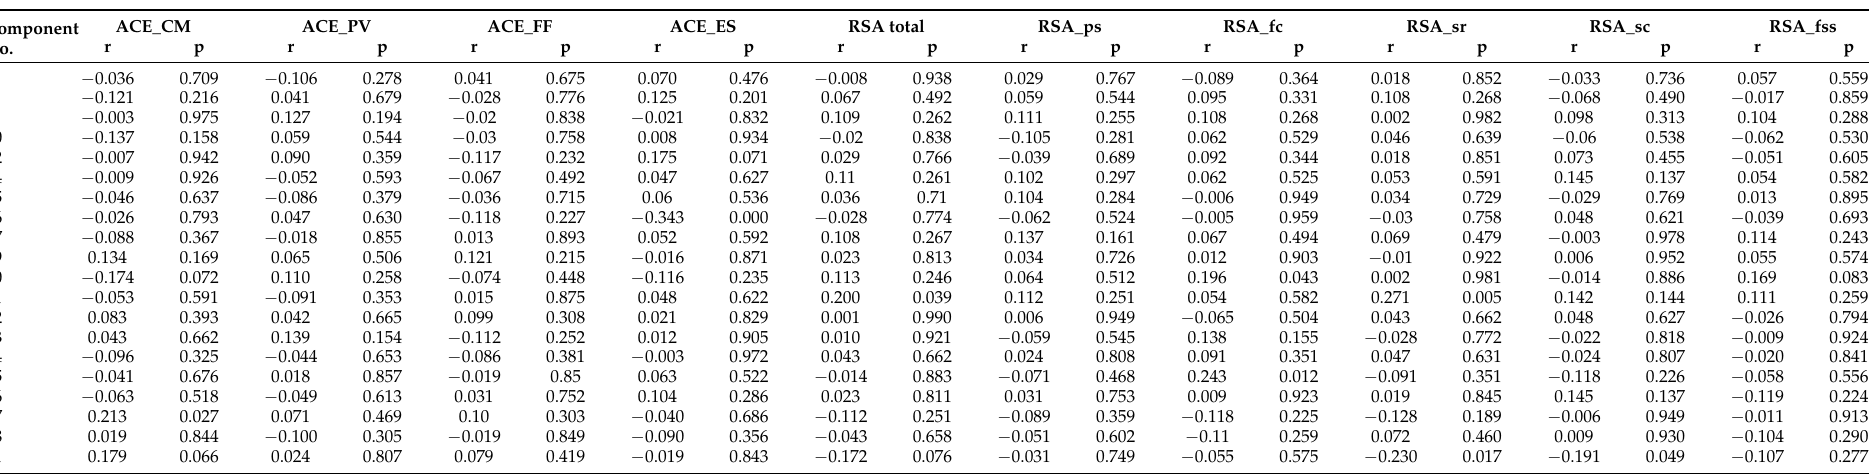
Table 2. The correlation matrix between independent components (ICs) and the RSA (Resilience Scale for Adults) subscales, as well as the ACE (Adverse Childhood Experiences)